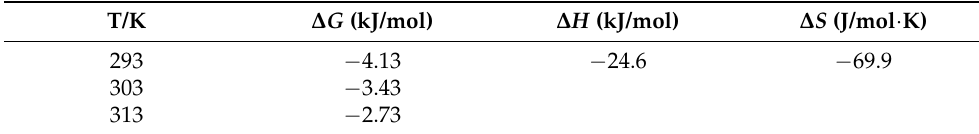
Table 3. Thermodynamic parameters at different